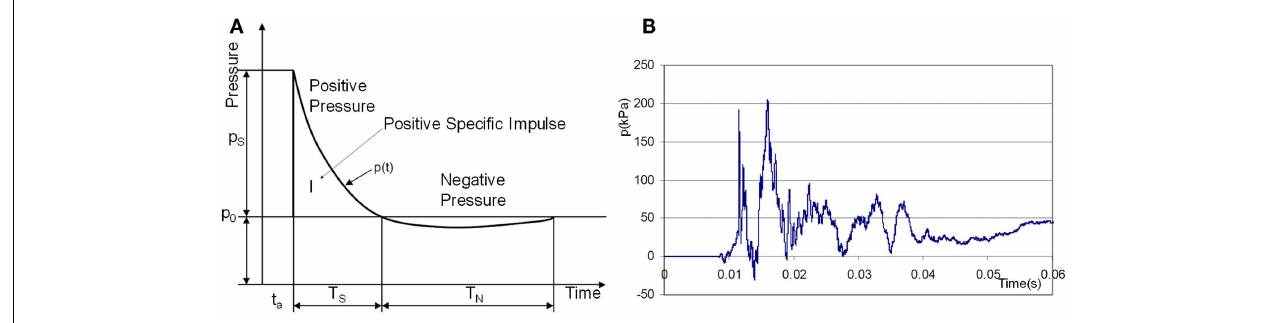
FIGURE 1 | (A) Ideal shock wave pressure profile (Friedlander curve) and (B) example of complex overpressure pattern inside a vehicle subjected to a blast mine (NATO,